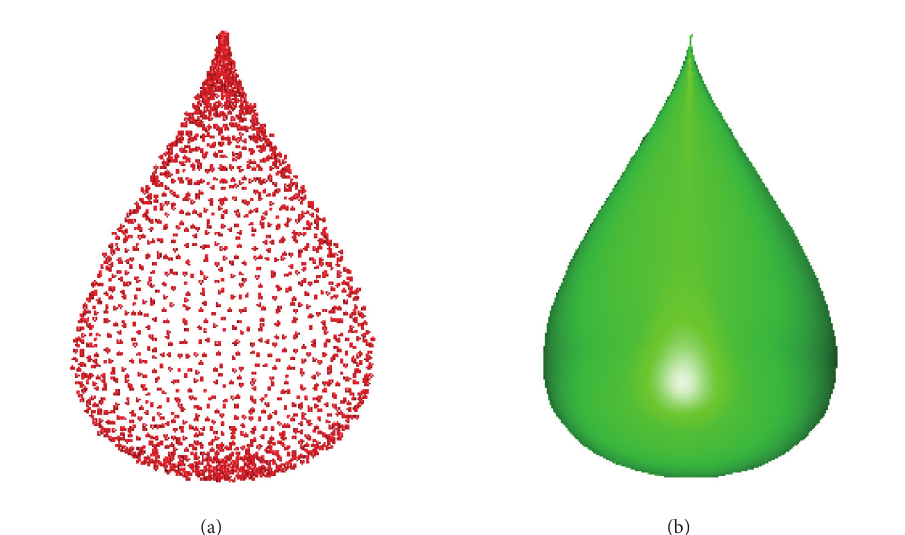
Figure 2: Applying the firefly algorithm to B´ezier surface approximation of data points: (a) original data points; (b) best approximating B´ezier